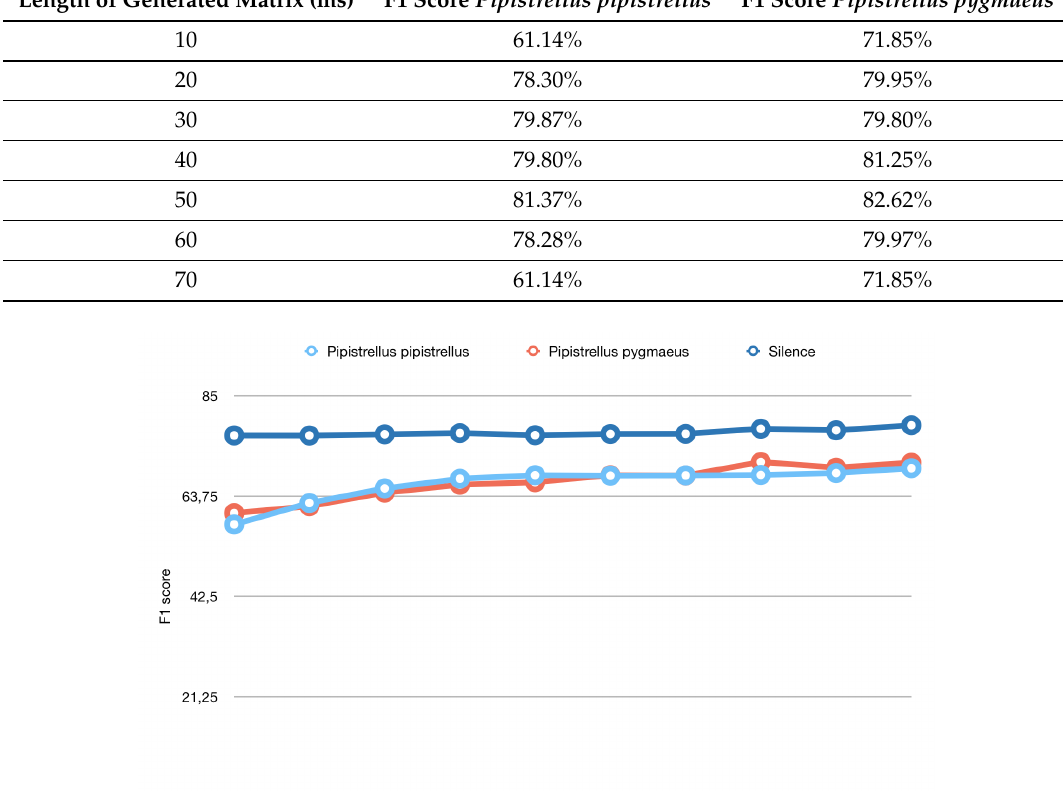
Table 4. Table of the length of the matrices with which the data was parameterized and their overall F1 score.